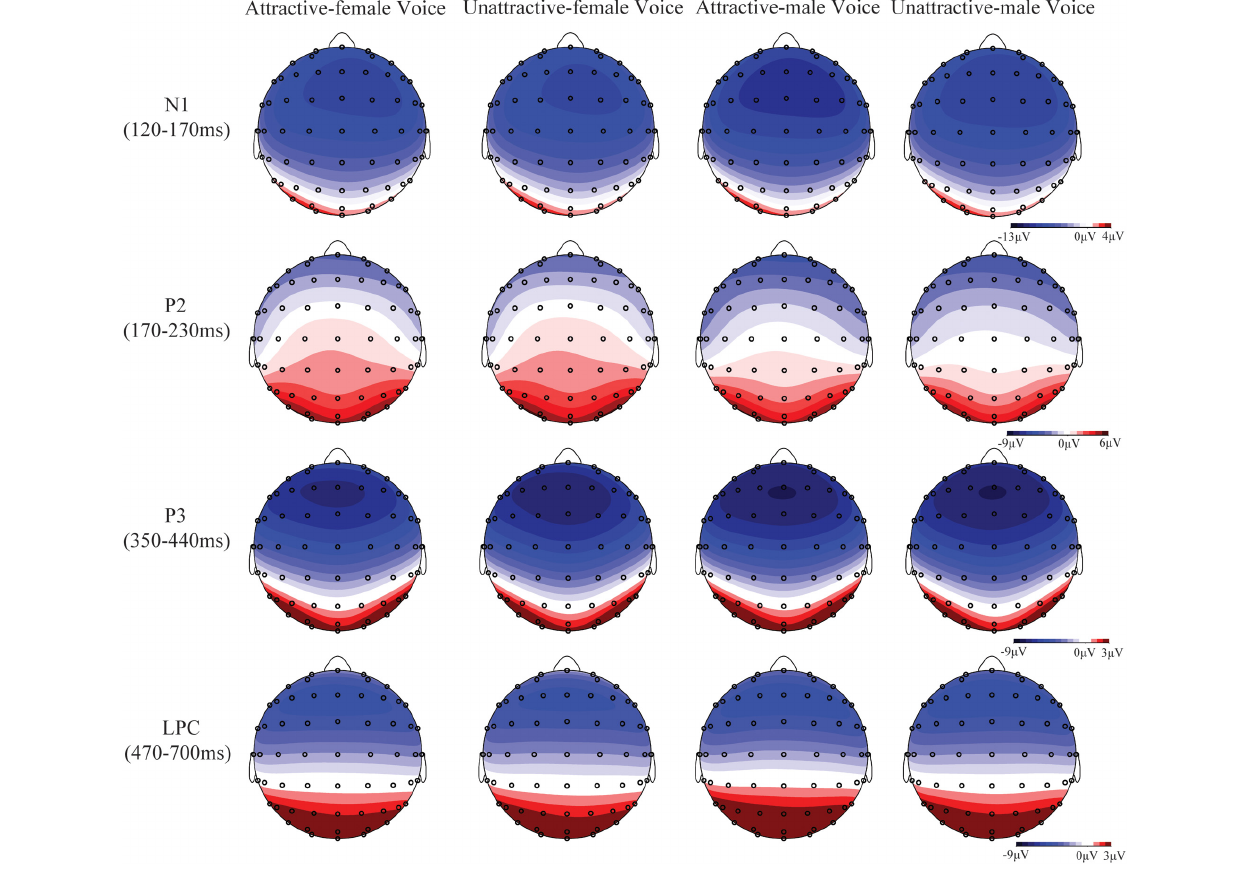
FIGURE 4 | Topography maps of voltage amplitudes for N1, P2, P3, and LPC in the four conditions.